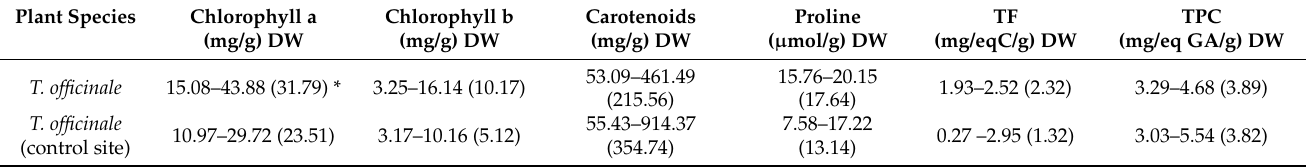
Table 4. Range of photosynthetic pigments (chlorophyll a, chlorophyll b and carotenoids), proline concentration, total flavonoids (TF) and total phenolic compound (TPC) in T. officinale (control site and studied plot) during vegetation period.